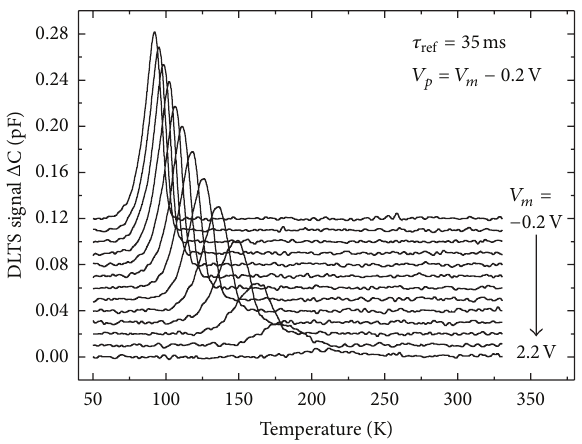
Figure 4: Charge-selective DLTS spectra for measurement voltages − 0.2V (forward direction) and 2.2 V (reverse direction) 𝑉 𝑚 between = 35 ms. The charging pulse and a reference time constant of 𝜏 ref amplitude is fixed to 0.2 V. The peaks for the deep hole states shift toward higher temperatures and decrease in